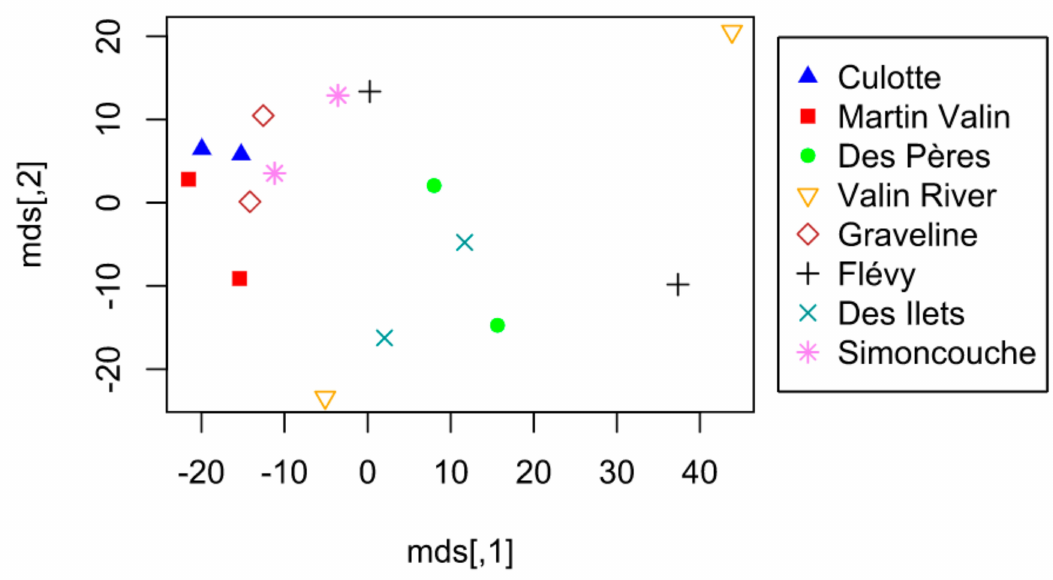
Figure 4. Multidimensional scaling (MDS) based on Euclidean distance comparing the temporal use of pairs of lodges on each of the studied water